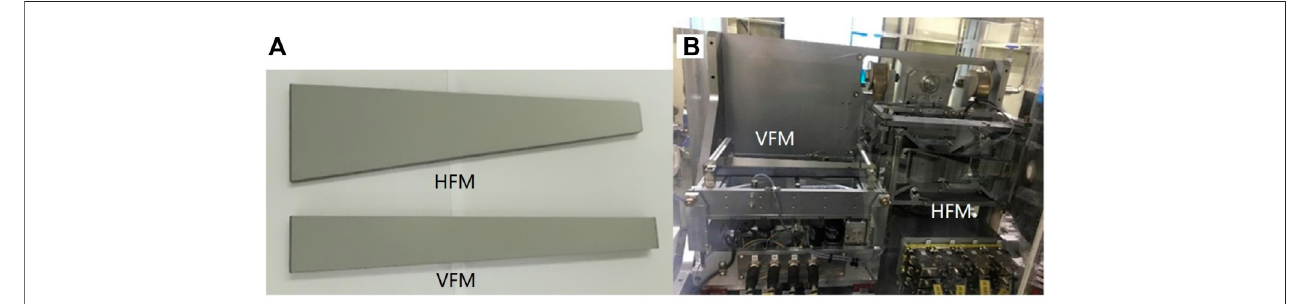
FIGURE 12 | (A) Pictures of two trapezoidal mirrors after coating and (B) after the installation in the bendable KB system.